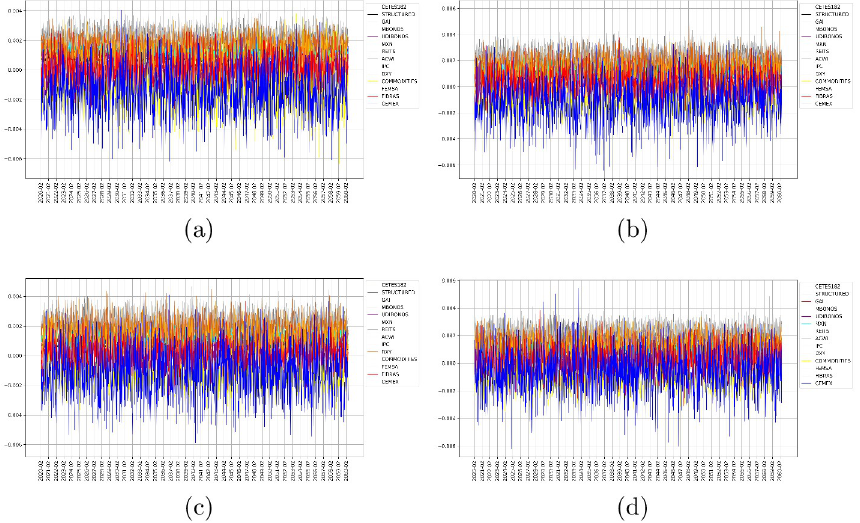
Fig 2. Forecast of expected returns. (a) Figure at top left: results obtained with EGARCH models. (b) Figure at top right: results obtained with the GJR model. (c) Figure at bottom left: results obtained with the GARCH model. (d) Figure at bottom right: results obtained with SBBS